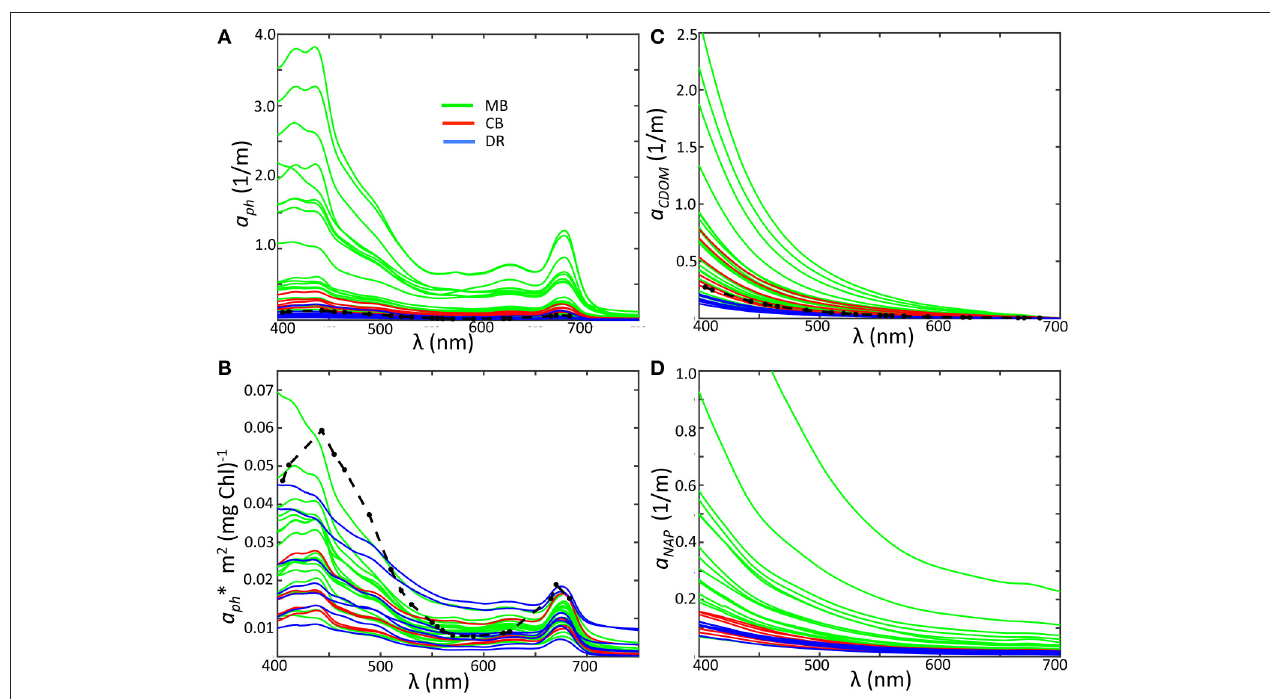
FIGURE 5 | (A) Phytoplankton absorption by region; (B) specific phytoplankton absorption; (C) Absorption of CDOM; (D) Absorption of non-algal particles. Colors indicate sub-region classification: Maumee Bay region, green; Central Basin region, red; Detroit River plume, blue. Ocean averages from the NOMAD data set are plotted as black dashed lines for a ph , a CDOM , and a ph